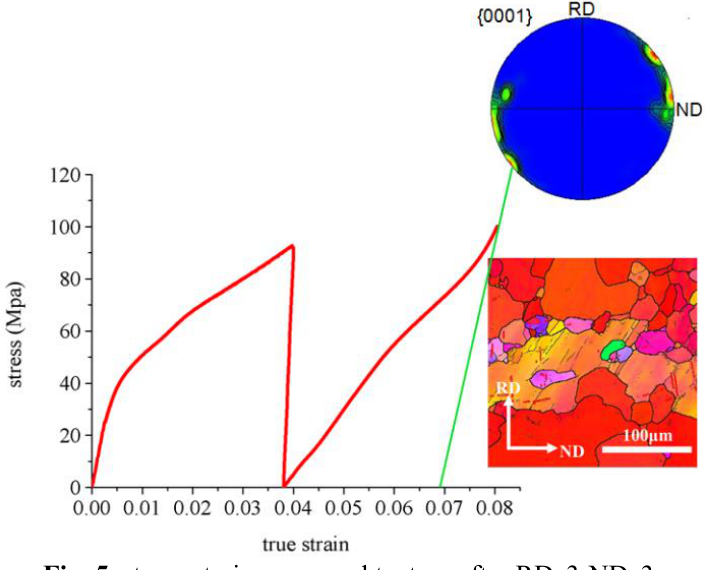
Fig. 5 . stress-strain curve and texture after